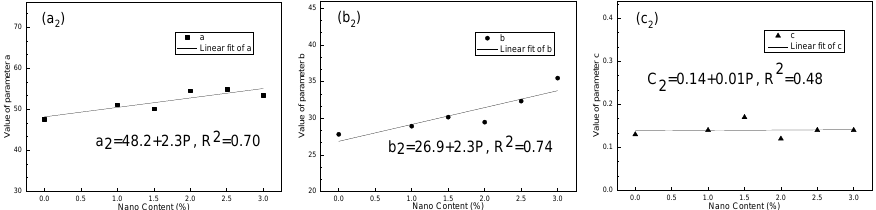
Figure 4. Relationships between compressive strength parameters value and nano content. ( a 2 ) Correlation between parameter a 2 and NS content; ( b 2 ) Correlation between parameter b 2 and NS content; ( c 2 ) Correlation between parameter c 2 and NS content.